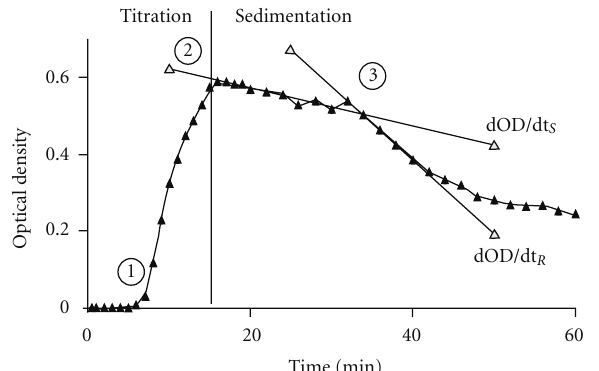
Figure 1: Spectrophotometric crystallization curve: (1) start of increase of optical density (OD) reflecting crystal concentration in urine, (2) maximal OD (mOD) reached at the end of oxalate titration, (2)-(3) slow OD decrease (dOD / dt S ) by sedimentation of single crystals, and (3) start of rapid OD decrease (dOD / dt R ) indi- cating crystal